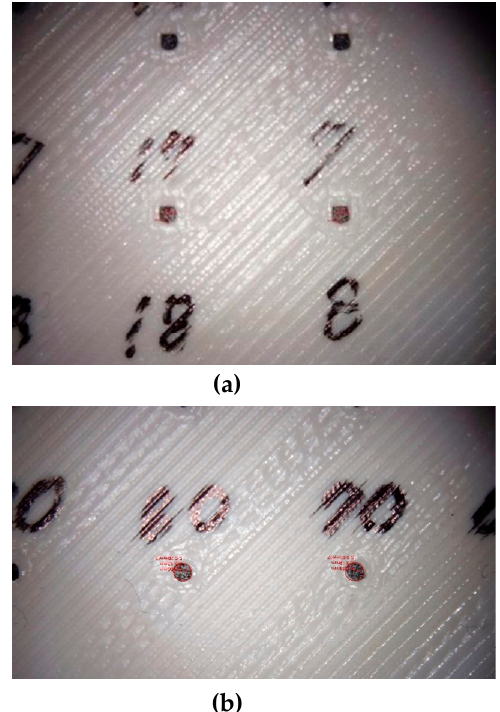
Figure 1. Examples of the magnified photograph of a portion of ( a ) a square hole sample (Specimen #2) and ( b ) a circular hole sample (Specimen #3).